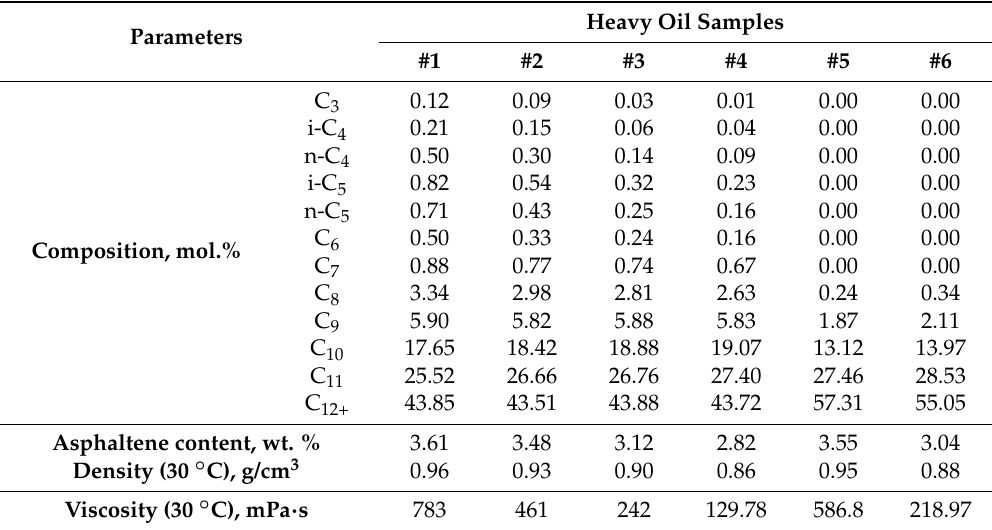
Table 1. The information of heavy oil samples used in this paper. Parameters